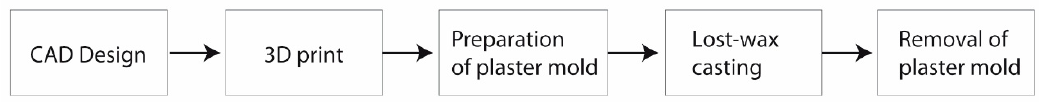
Figure 2. Scheme of process to realize metal foam designed in this paper.